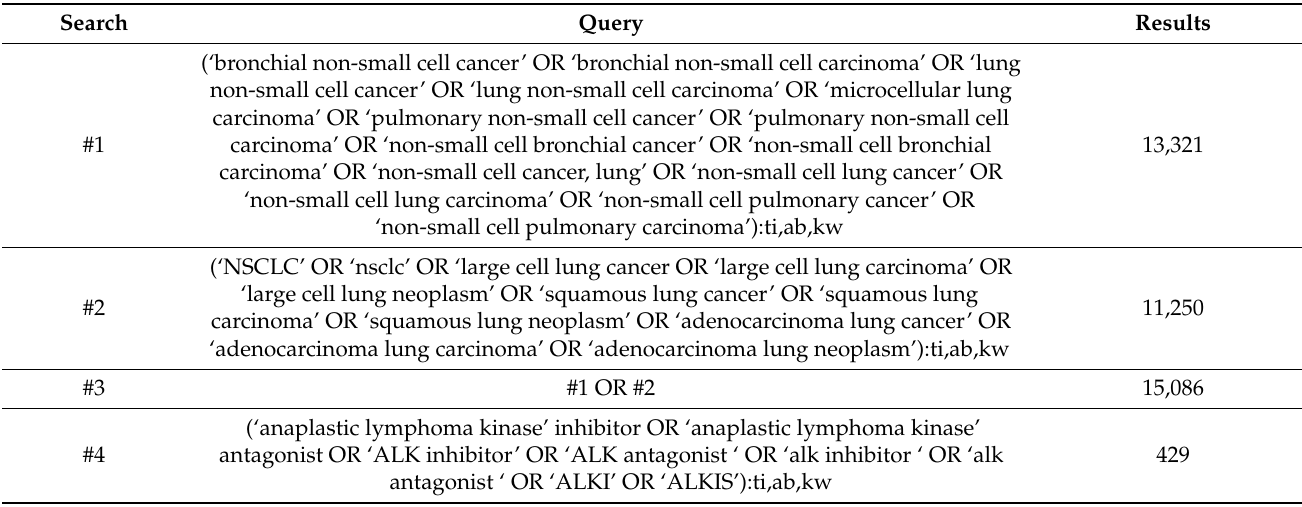
Table A2. Search strategy in the Cochrane Library (CENTRAL and